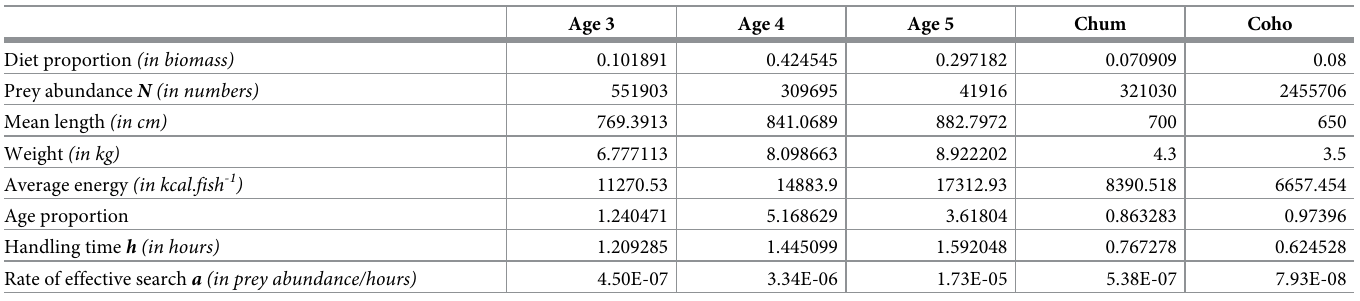
Average energy (in kcal . fish -1